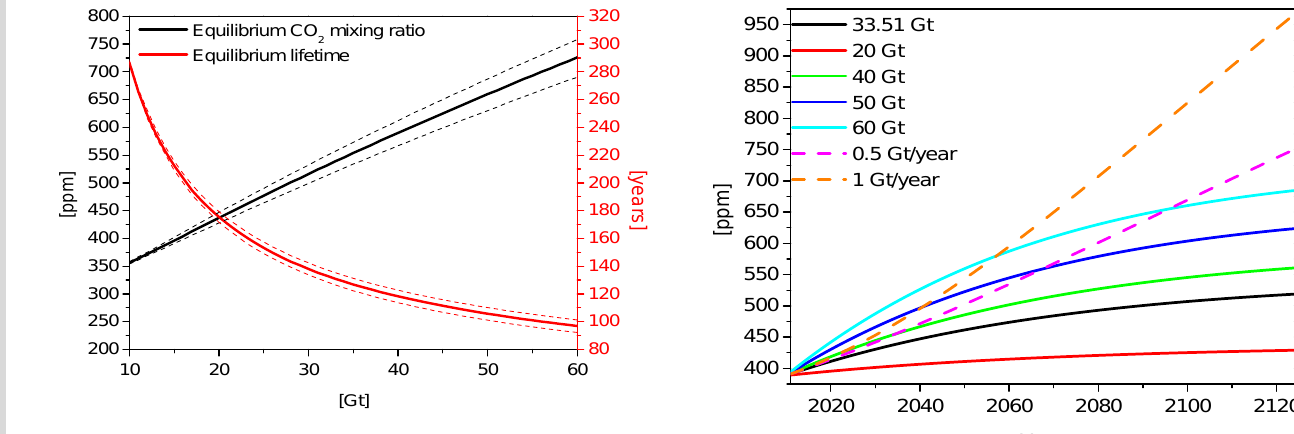
Fig. 3. Equilibrium mixing ratio in ppm of CO 2 for constant emis- sion rates between 10 and 60Gtyr − 1 (black line) and the corre- sponding equilibrium lifetime (red line). The corresponding dashed lines represent upper and lower limits calculated from input data ac- cording to the upper and lower limits of their uncertainties (Fig. 1).